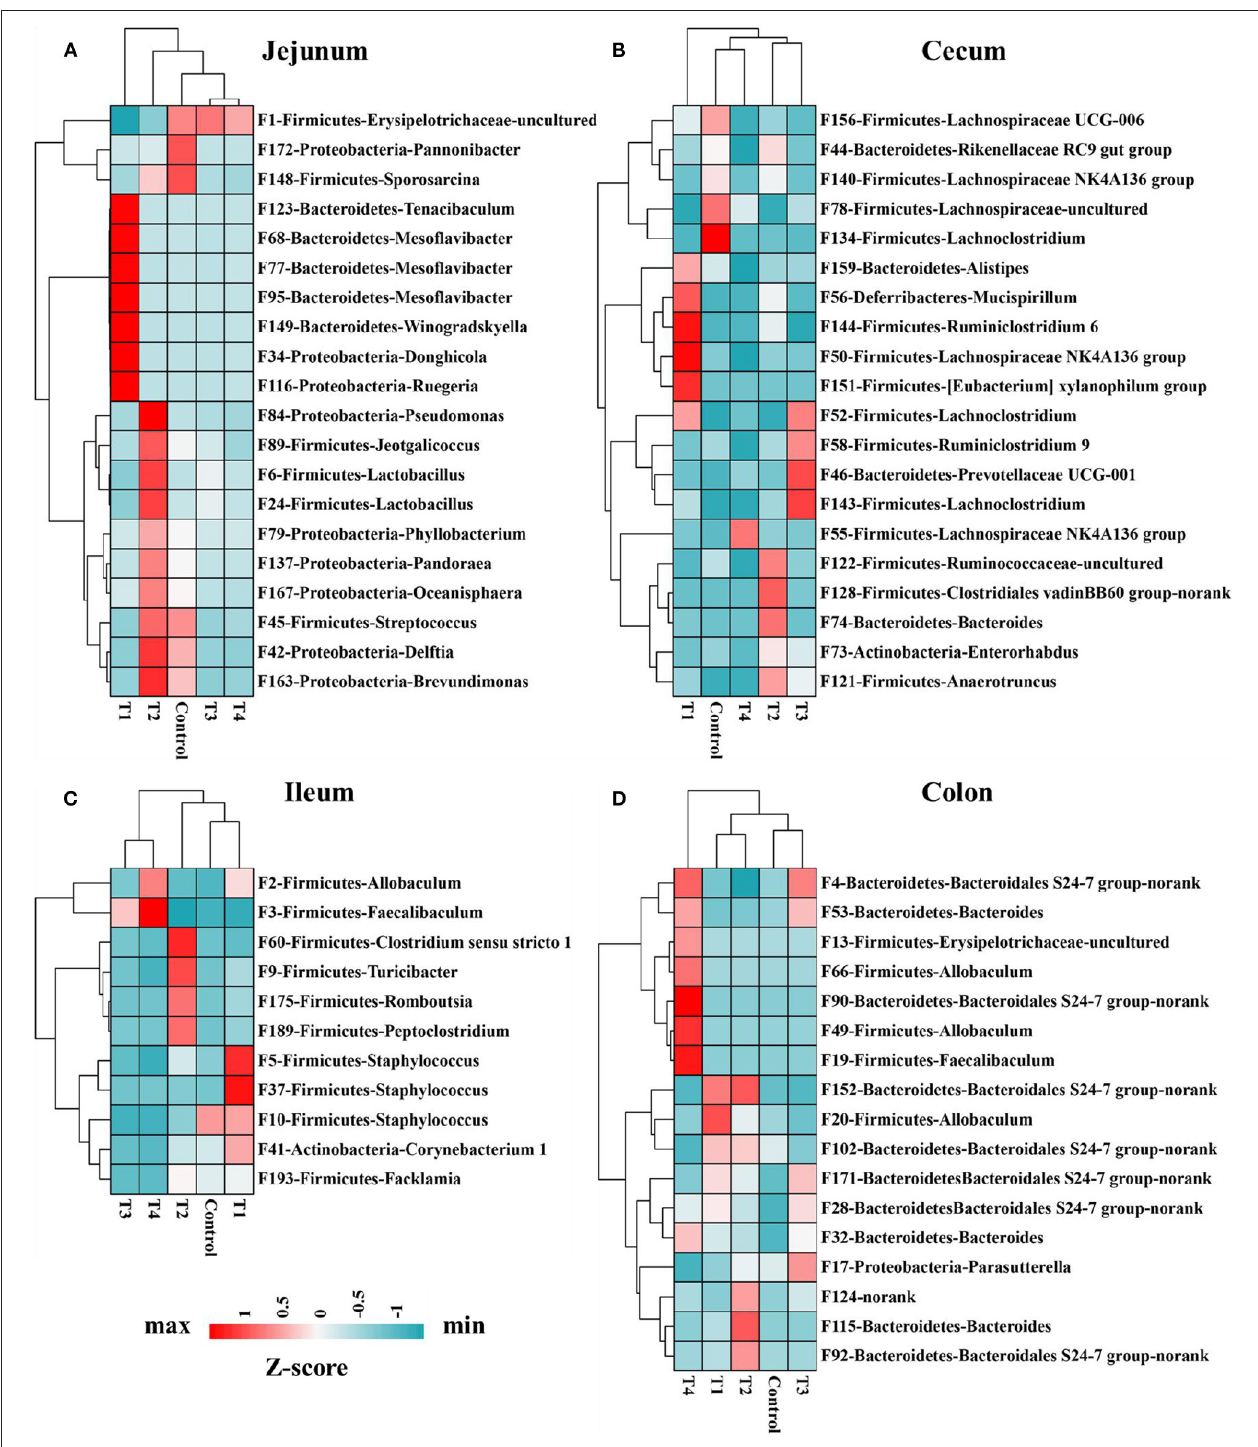
FIGURE 6 | Heat map indicated 68 bacterial taxa were identified by LEfSe (LDA > 3) in mice jejunum ( n = 20) (A) , ileum ( n = 11) (C) , cecum ( n = 20) (B), and colon ( n = 17) (D) microbiome. The top 1,000 features were used for LEfSe analysis. Heat map shows the average relative abundances on a Z-score. and Firmicutes-Allobaculum (F66, F49) in T4 group increased to ileal ROR γ T and IL-17 levels (56), induced susceptibility significantly than other groups (Control, T2, T3). Allobaculum to autoimmune encephalitis (57), increased the expansion is not only positive related to diabetes (47, 48), but also related of inflammatory T helper 17 cells in gut (58). So, low